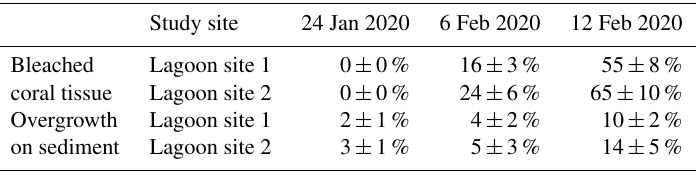
Table 3. Change in the relative percent area (mean ± SD) of coral tissue exhibiting paling or bleaching (bleached coral tissue) and relative percent area (mean ± SD) of sediment exhibiting overgrowth in the form of visible cyanobacteria mats or Chlorophyta growth (overgrowth on sediment) over the course of three different survey efforts. Data for each date are pooled across parallel transects within each lagoon site ( n = 120 per site).